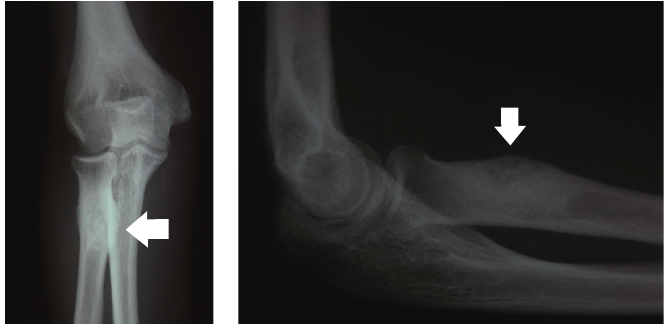
Figure 1: Radiograph images of the patient’s elbow upon initial examination. Periostitis’ signs and an image of “onion leaves” along with bone sclerosis at the bicipital tuberosity of the radius.